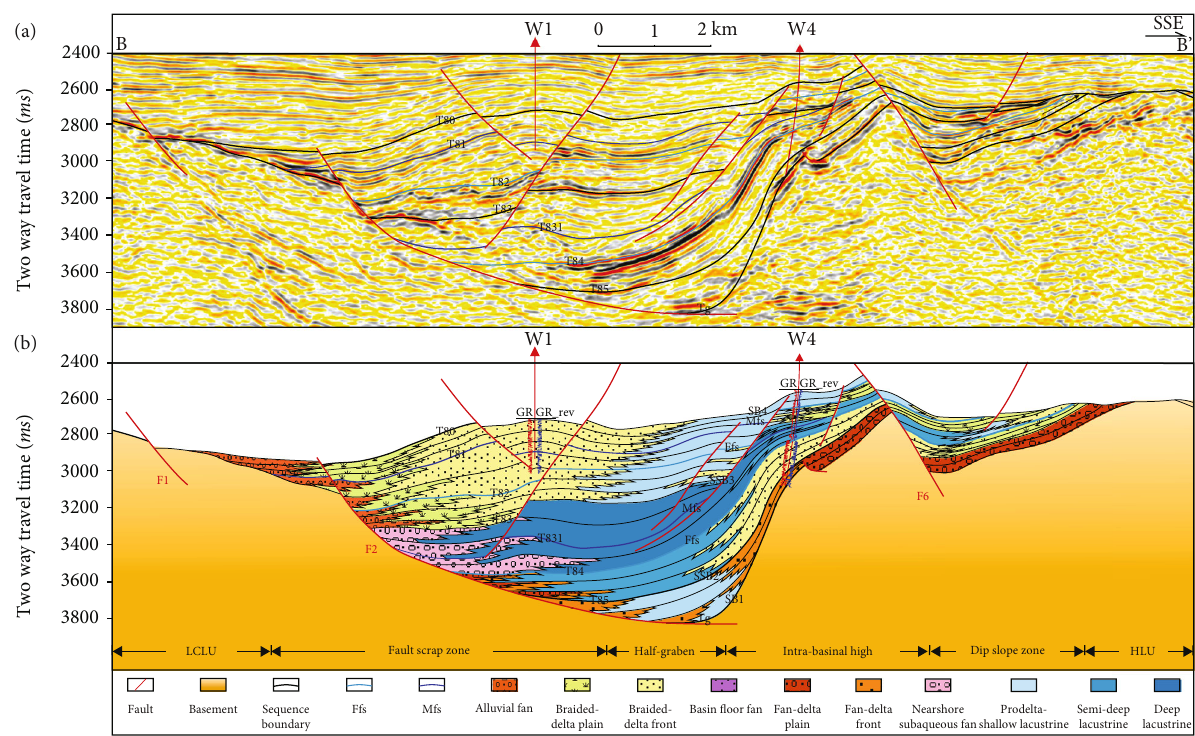
Figure 6: Pro fi les (crossing W1 and W4) in the central part of LF13E. (a) Seismic pro fi le interpretation of faults and horizons. (b) Interpretation of depositional systems based on well and seismic re fl ection data. Location of pro fi le BB ’ is marked in Figure 1(b) (modi fi ed from [37]).